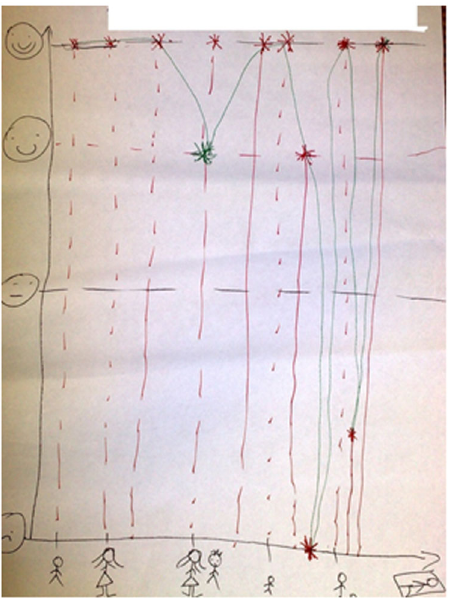
Fig. 3 Life histories. Flipchart recording one participant ’ s evaluation of her happiness over the life cycle. From left to right on the horizontal axis: childhood, adolescence, marriage, motherhood and parenting, old age (represented by being a grandmother), and death. From bottom to top on the vertical axis, smiley faces mark levels of happiness from unhappy to neutral, happy and very happy. Participants marked their happiness level against each stage of their lives depicted on the horizontal axis with an asterisk as they shared their story with the group. Once the narration was complete, the research assistant would help participants join the asterisks, tracing participants' wellbeing over their lifetime and summarising their story. This activity served as closure and validation for the participant who had shared her personal story, and clari fi ed any misunderstandings.